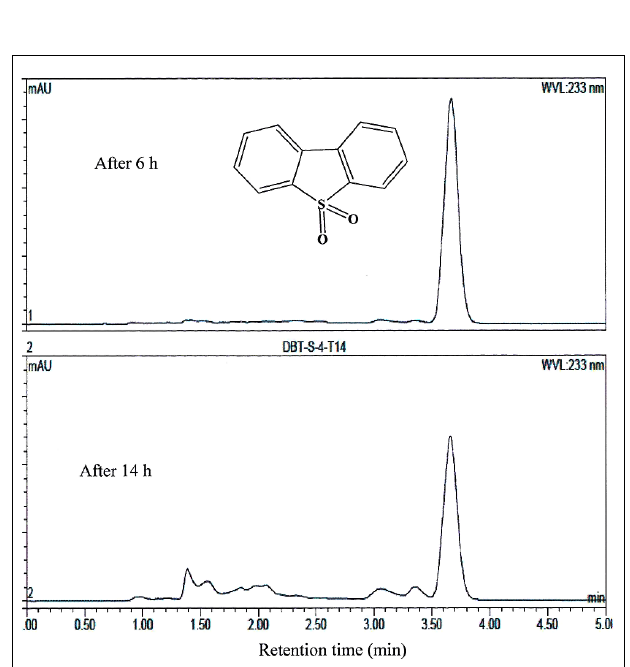
FIGURE 4 | HPLC analysis showing the utilization of DBT by AK6U grown in sulfur-free minimal medium containing DBT as a sole sulfur source and glucose as a carbon source. The chemical structure of DBT is shown and refers to the major peak in the chromatogram (retention time 18 min).